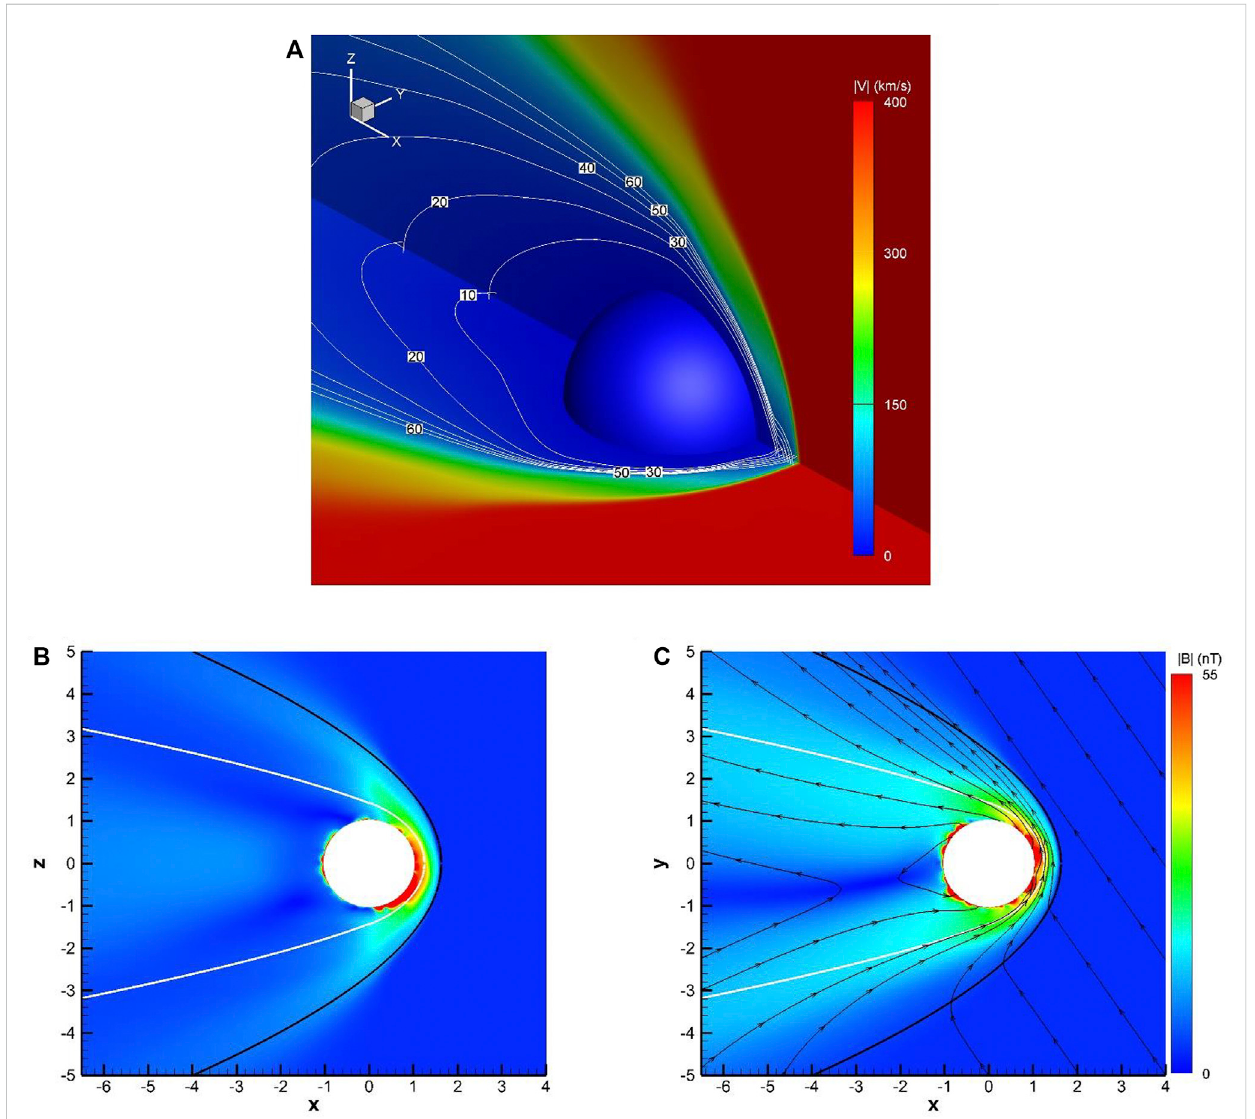
FIGURE 2 (A) Distributions of the plasma velocity in the x-y and x-z plane. The blue spherical surface is the inner boundary of the model. The white lines with labels are the isocontours of |V| = 10 – 60 km; (B, C) Distributions of the magnetic fi eld in the x-z (B) and x-y (C) plane. White and black solid quasi- parabolas represent the mean locations of MPB and BS from Vignes et al. (2000), respectively. The black curves with arrows in (C) is the magnetic fi eld